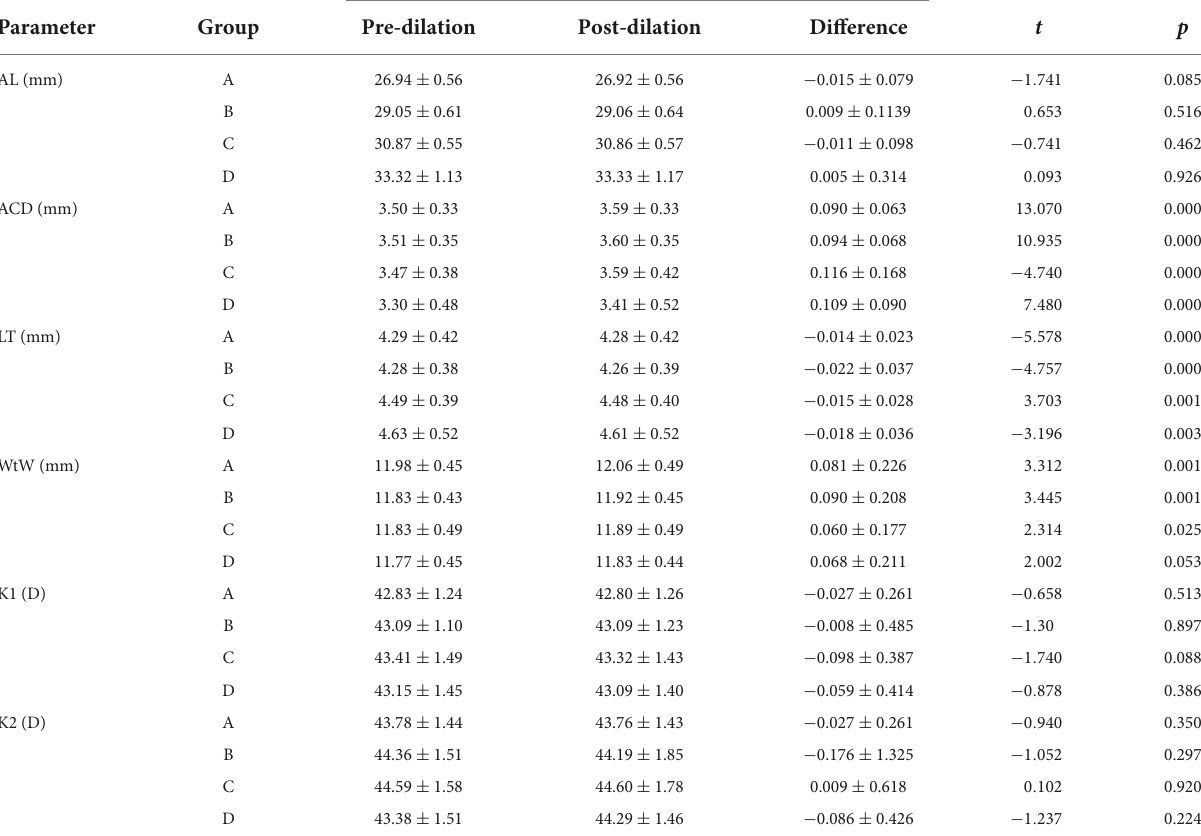
TABLE 1 The biometric data obtained using IOLMaster 700 before and after pupil dilation.